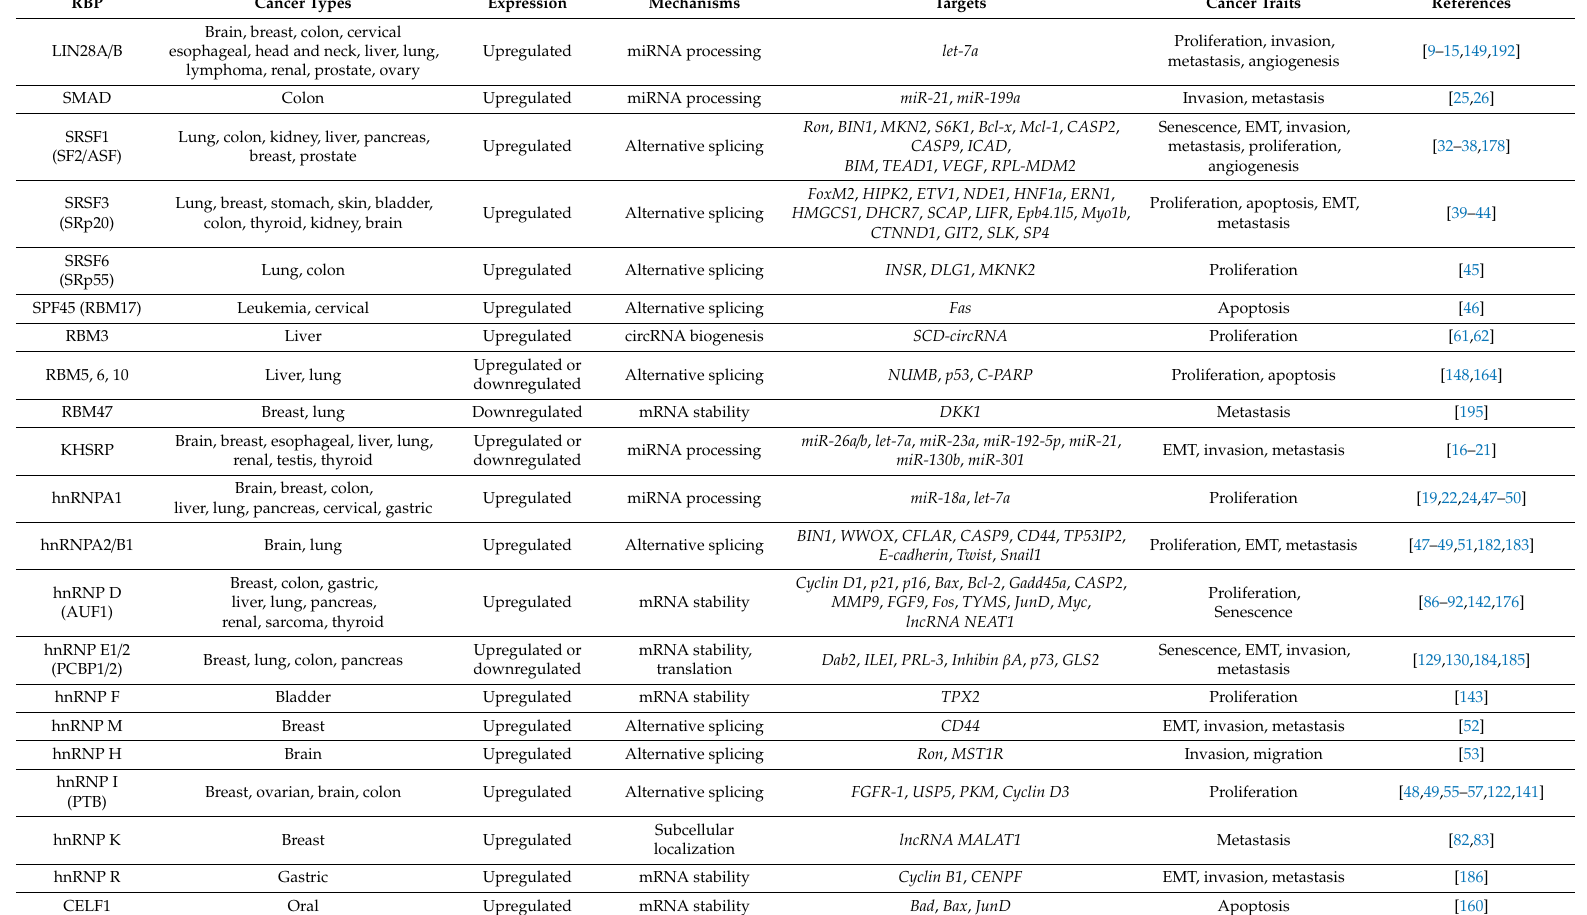
Table 1. Roles of RNA binding proteins (RBPs) in